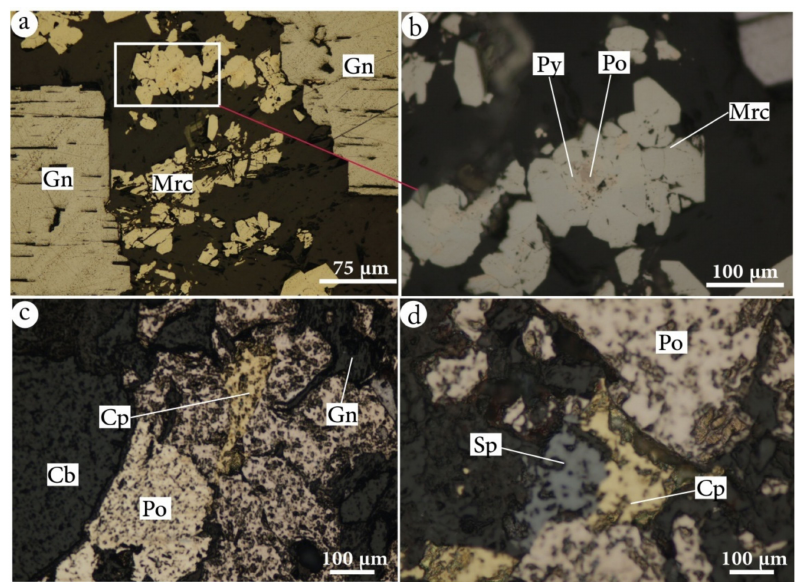
Figure 15. Microphotographs of ore minerals assemblage in the NNE-A (microscopic observation in reflected light; RL). ( a , b ) Pyrite and pyrrhotite relics in marcasite crystals, disseminated in a calcite vein that intersects galena; ( c , d ) pyrrhotite, chalcopyrite, galena and sphalerite in quartz-carbonate veins. Po: Pyrrhotite; Sp: Sphalerite; Cp: Chalcopyrite; Gn: Galena; Py: Pyrite; Mrc: Marcasite; Cb: Carbonates.